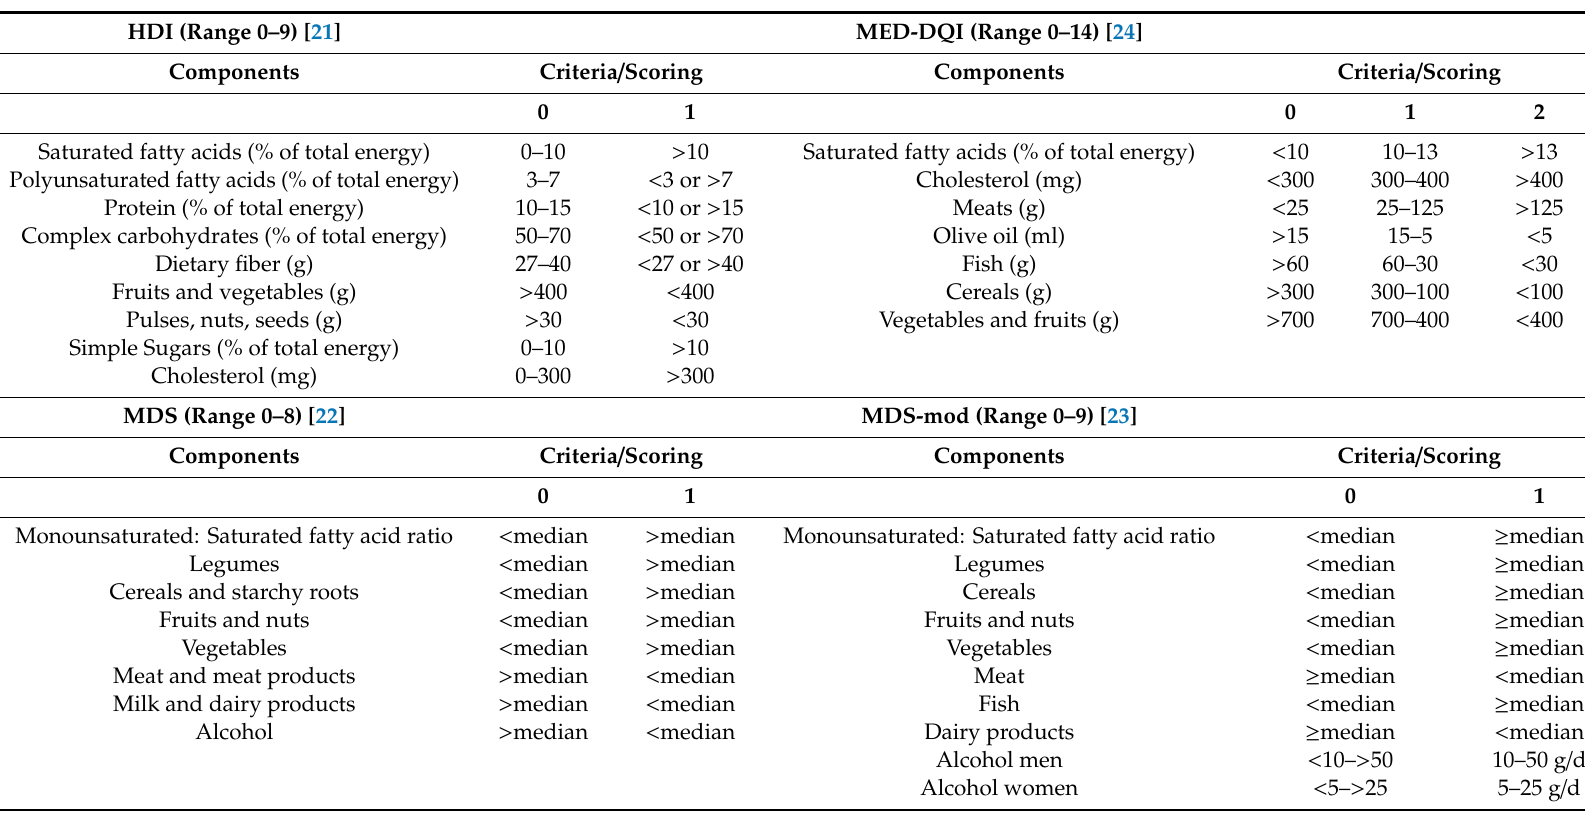
Table 1. Characteristics of the Healthy Diet Indicator (HDI), the Mediterranean-Diet Quality Index (MED-DQI), the Mediterranean Diet Score (MDS), and the Mediterranean Diet Score-modified